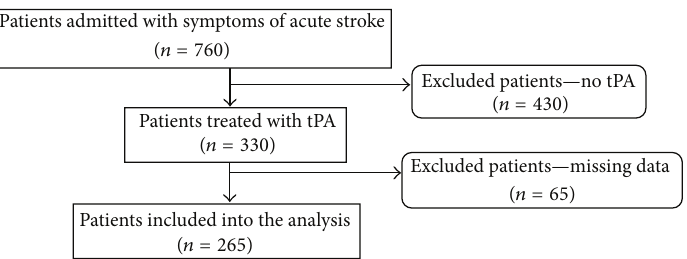
Figure 1: The registry was based on patients from a well-defined catchments area admitted with symptoms of acute stroke to Copenhagen University Hospital, Bispebjerg, from April 2009 to December 2011. Patients treated with tPA and no missing or undecipherable values of admission systolic blood pressure, admission-NIHSS, and prehospitalization mRS were included into the analysis; patients not treated with tPA or with missing or undecipherable values were excluded from the analysis.